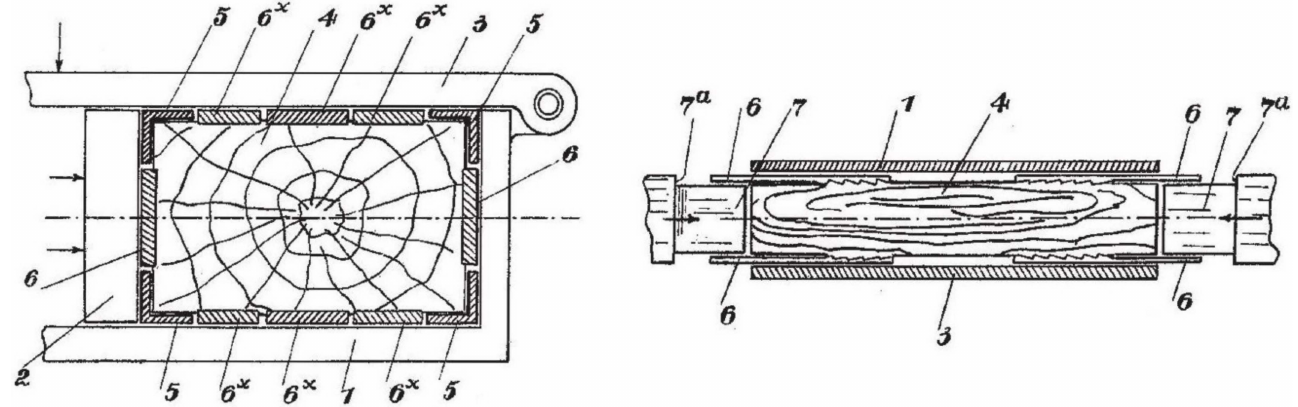
Figure 3. Sections of the compressing machine. Reproduced from [50]. The arrows indicate the direction of the forces. Abbreviations: 1—side wall of the press; 2—side wall of the press; 3—side wall of the press; 4—workpiece; 5—angle iron; 6—mobile supporting plates; 6 x —serrated mobile supporting plates; 7—press plate; 7 a —piston